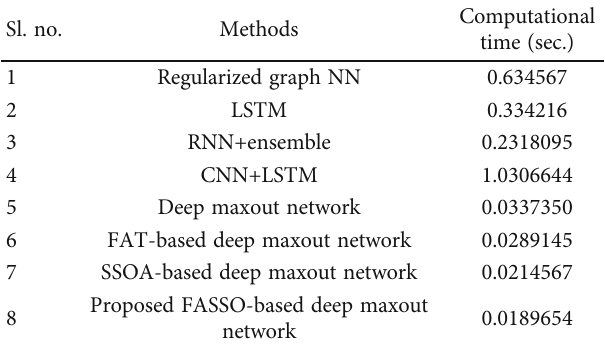
Table 2: Computational cost. Sl.